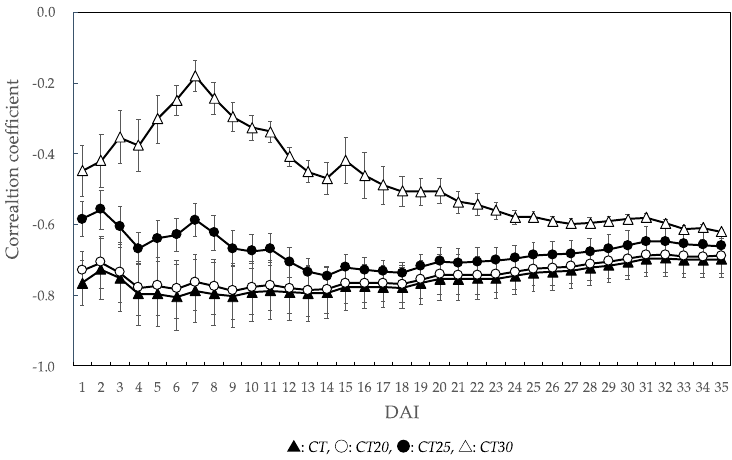
Figure 4. Changes in the correlation coefficients for each temperature factor according to the unaffected seedling rate of each P . thunbergii family. The value of the correlation coefficient in this figure is the mean value of six families. Error bars represent SD. DAI: days after inoculation. Temperature factor abbreviations: CT , CT 20, CT 25, and CT 30 are represented cumulative temperature with different thresholds (0 °C, 20 °C, 25 °C, and 30 °C) from the day of inoculation to the n DAI.